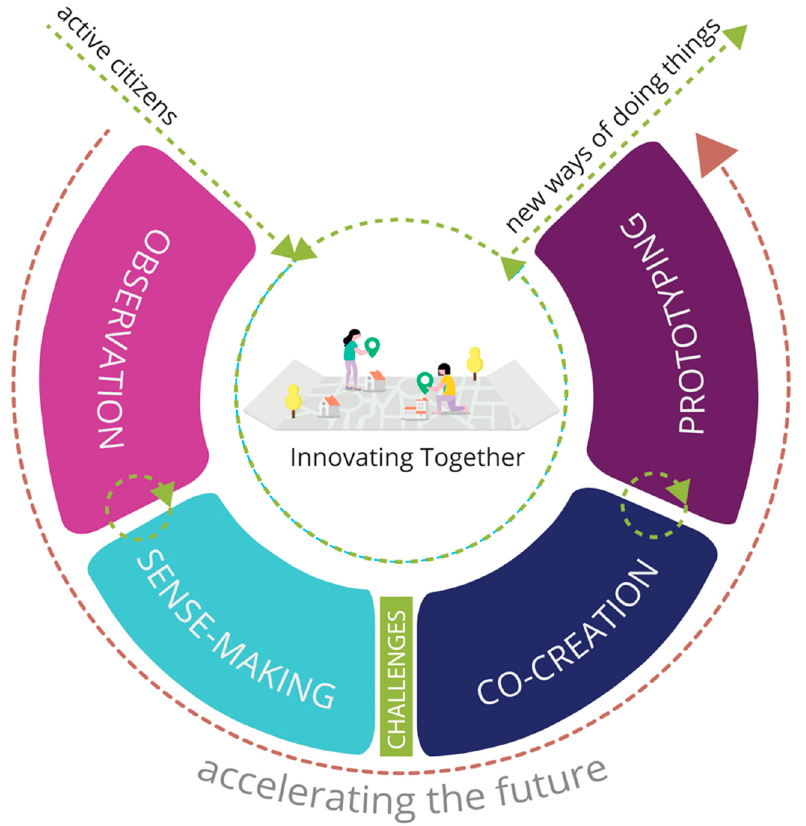
Figure 4. Innovation Playground ‘Journey’ (Source: [5]).